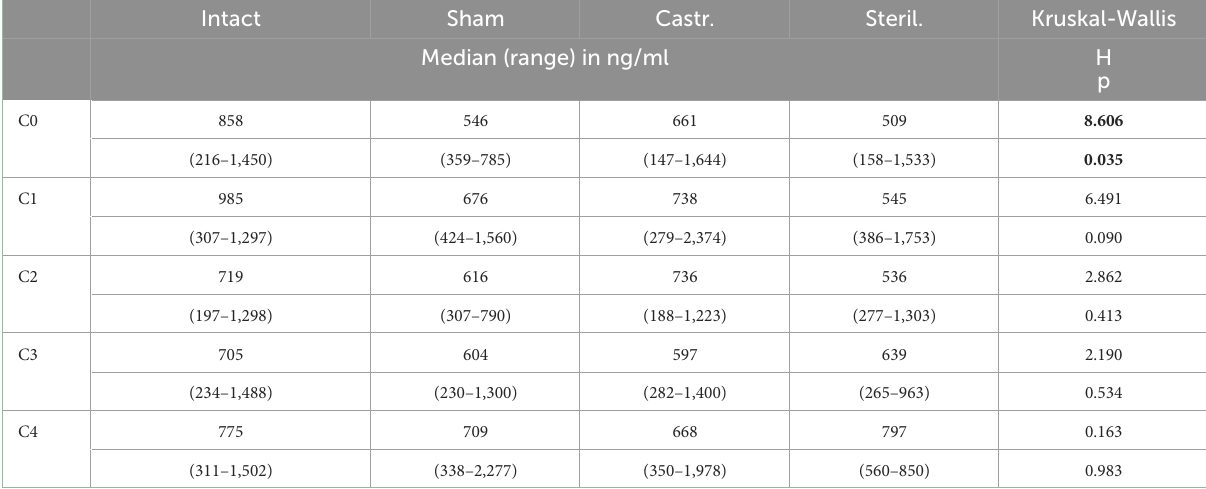
TABLE 3 Median, range and statistical parameters of cortisol concentrations of females living together with intact ( n = 20), sham-operated ( n = 16), castrated ( n = 28), and sterilized ( n = 8) females. Intact Sham Castr. Steril.